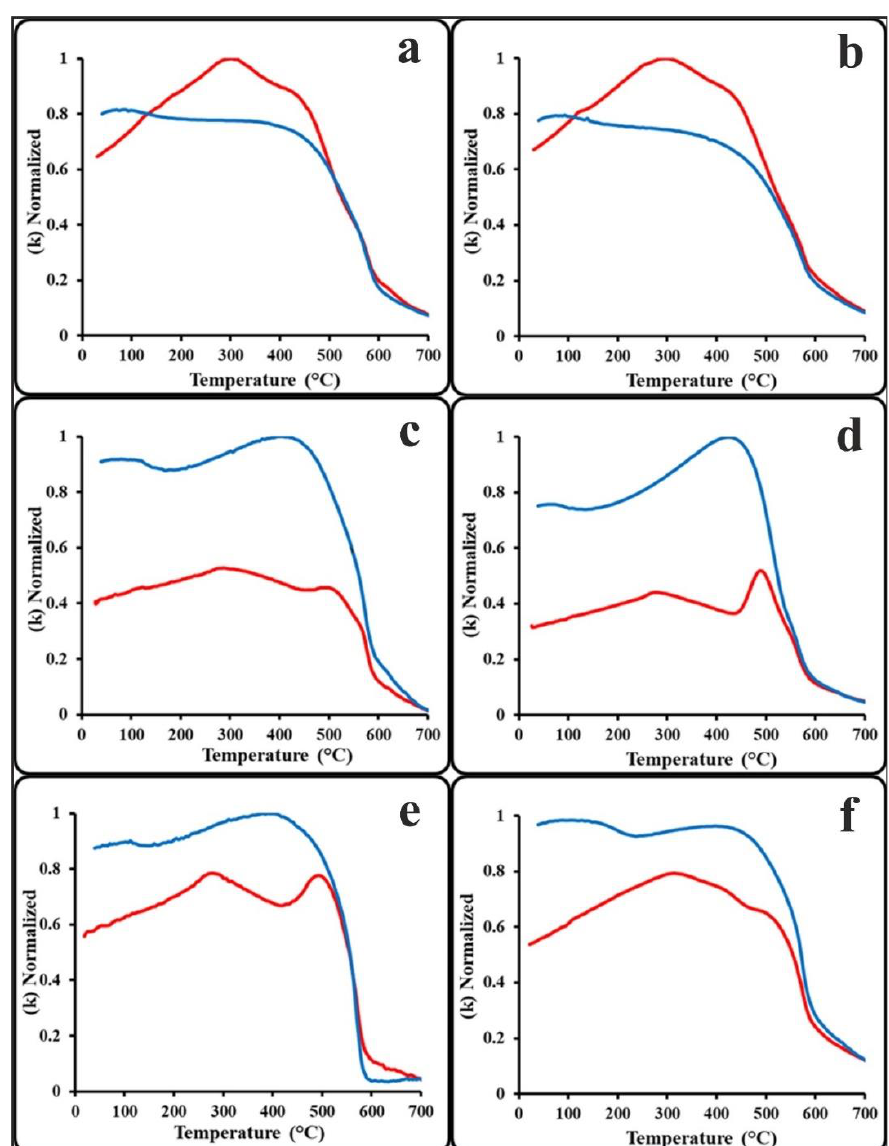
Figure 7. Thermomagnetic analysis (k – T curves) of representative soil sample for different land uses: agricultural ( a , b ), industrial ( c , d ), and urban ( e , f ); heating curve ( red ), cooling curve ( blue ).